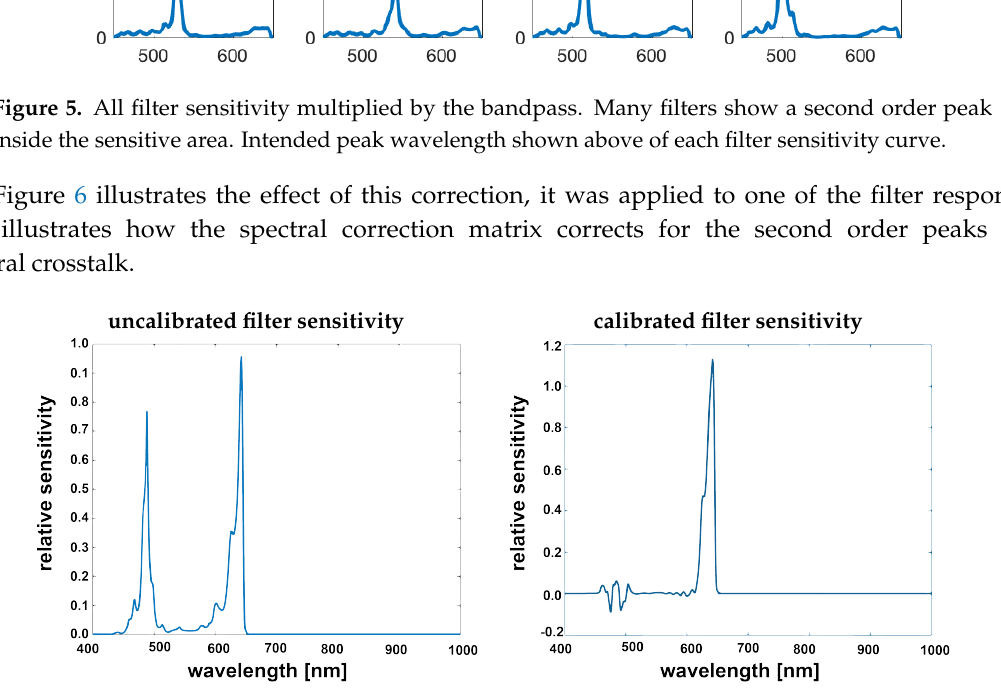
Figure 6. Filter sensitivity given by manufacturer [27] from the calibration file ( left ) filter band-passed showing clear second order harmonics, corrected filter after applying the spectral correction ( right